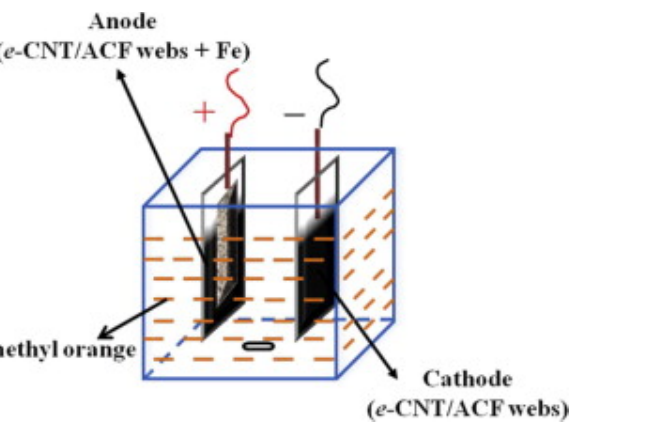
Figure 2. Scheme of the electrolytic cell used for methyl orange degradation. Reprinted from [68], with permission from Elsevier.